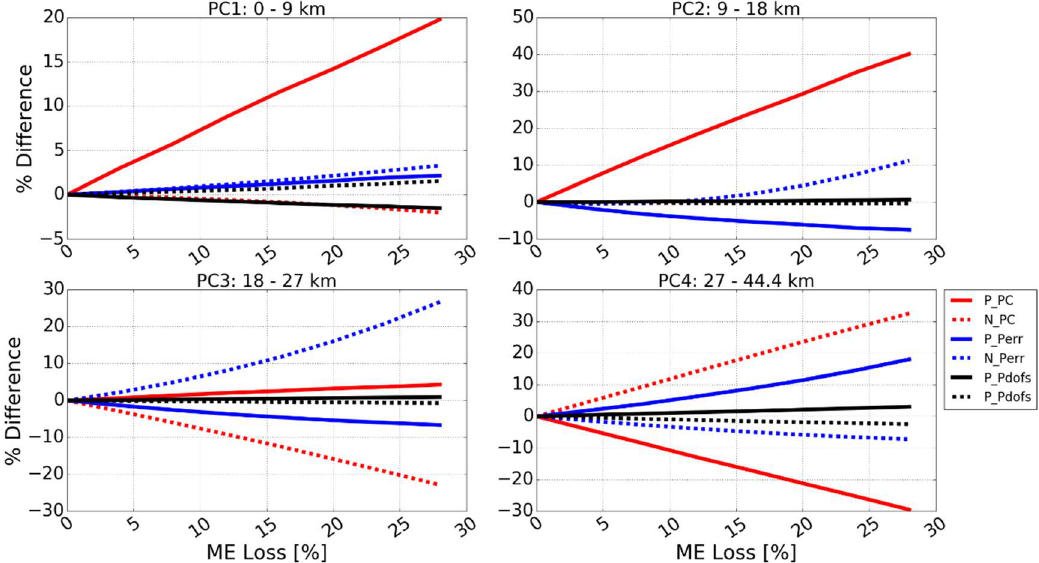
Figure 2. Sensitivity of the partial column, partial error, and partial degrees of freedom (DOFs) at each partial layer for O 3 with respect to the modulation efficiency (ME) deviation. The solid red line (P_PC), solid blue line (P_Perr), and solid black line (P_Pdofs) represent the sensitivity of the partial column, partial error, and partial DOFs with respect to positive ME deviation, respectively. The dashed red line (N_PC), dashed blue line (N_Perr), and dashed black line (N_Pdofs) represent the sensitivity of the partial column, partial error, and partial DOFs with respect to negative ME deviation, respectively. The ME deviations were modelled by ALIGN60. The results were deduced from the spectra recorded at Hefei on 16 February 2016.